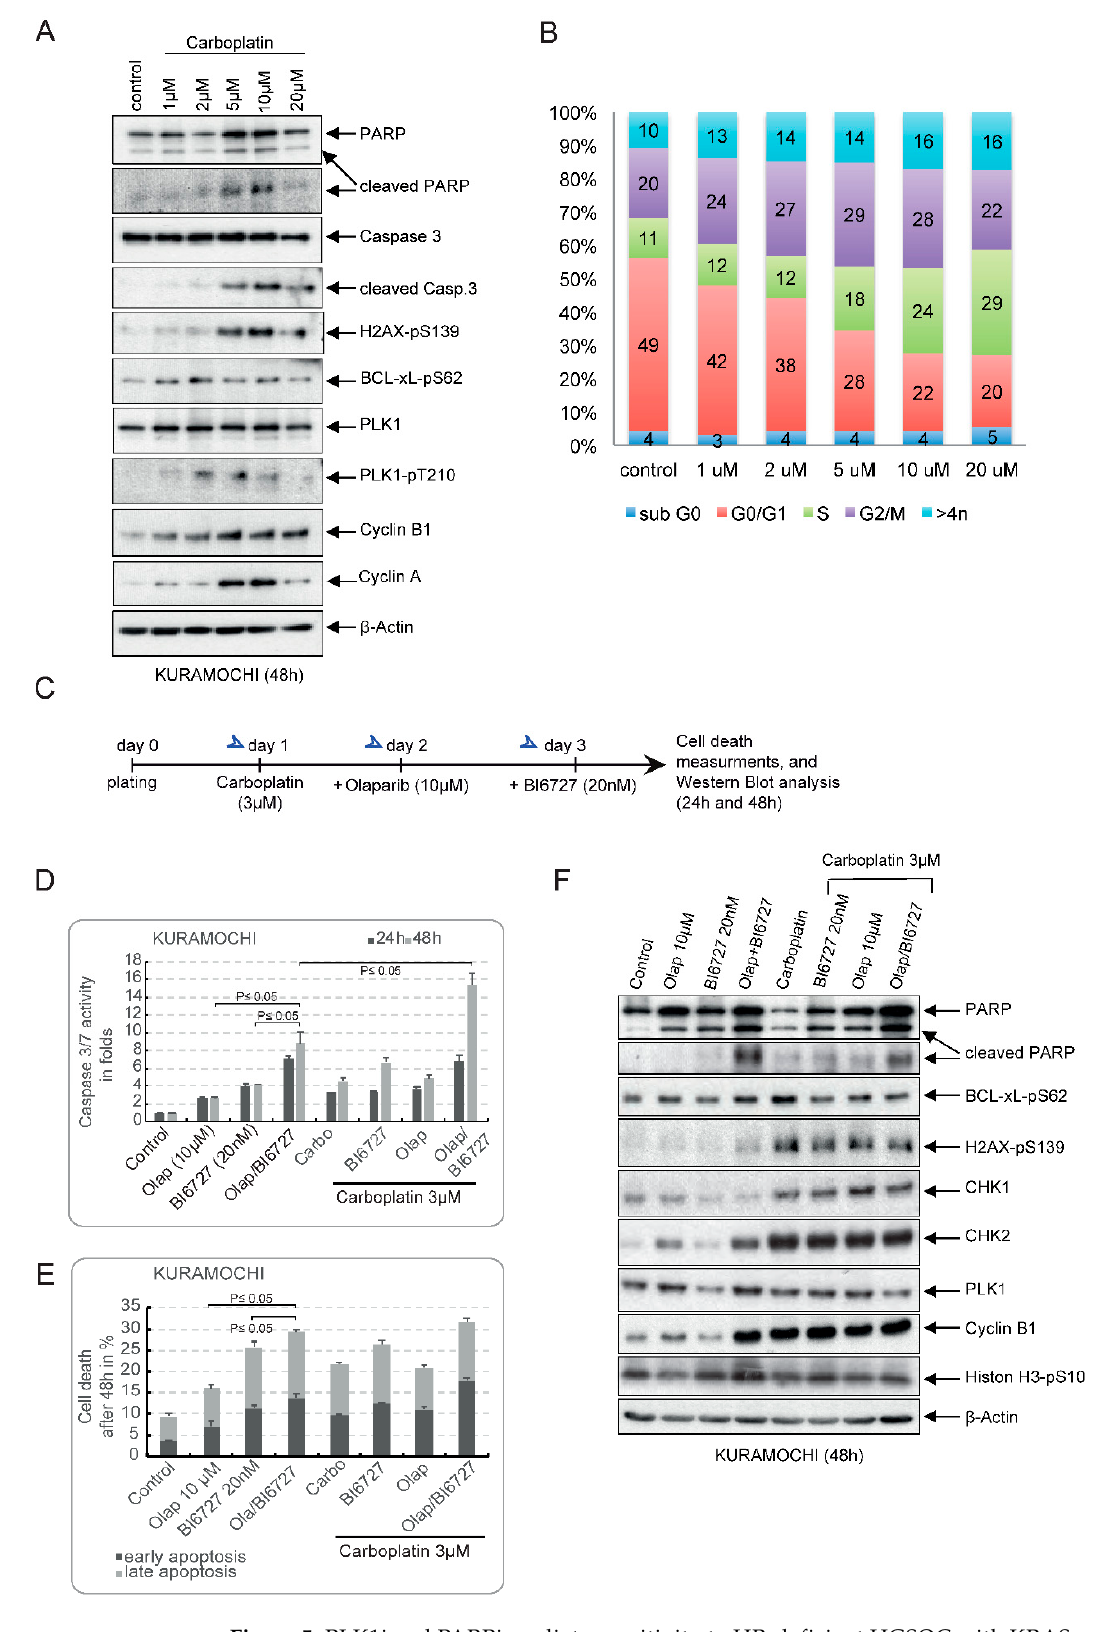
Figure 5. PLK1i and PARPi mediate sensitivity to HR-deficient HGSOC with KRAS amplification to Carboplatin. KURAMOCHI cells were treated with increasing concentrations of Carboplatin, 1 µM to 20 µM. Cells were harvested after 48 h. Cell lysates were prepared for Western blot using the indicated antibodies ( A ), and the cell cycle distribution of treated cells was analyzed using FACS ( B ). ( C ) Treatment schedule: KURAMOCHI cells were treated with Carboplatin (3 µM) on day 1.